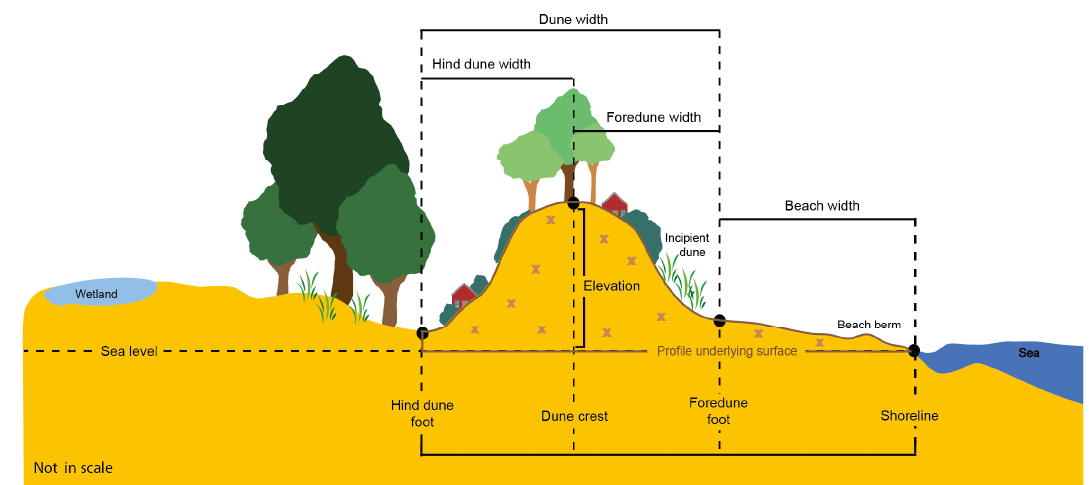
Figure 2. Dune zonation, metrics, and terminology used in the present paper. Grasses and creepers are the pioneer colonizers of sand dunes (primary species) in the succession process that stabilizes the dune foot and foredune; shrubs and short ‐ lived trees (secondary species), and long ‐ lived trees (tertiary species), form a protective and more stable coastal forest.